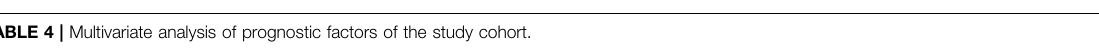
TABLE 4 | Multivariate analysis of prognostic factors of the study cohort. Variable Multivariate